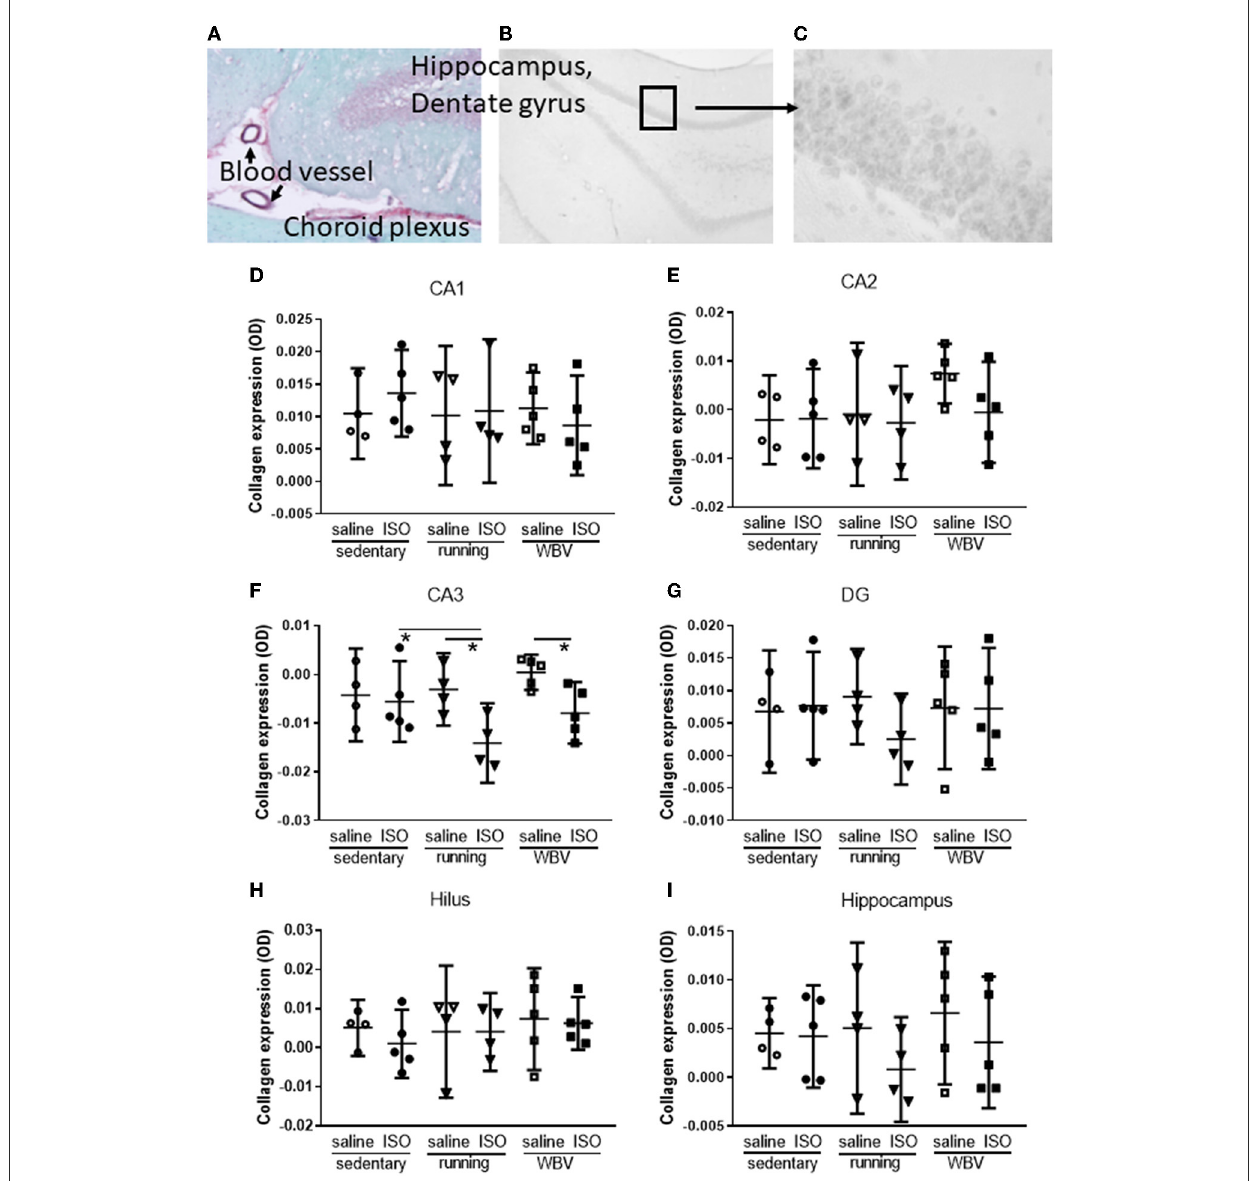
FIGURE4 (A) Example of hippocampal dentate gyrus stained with Sirius red (red) and Fast green (green), showing positive staining for collagen (red) in blood vessel walls, fibrous tissue of the choroid plexus, and the granular layer of the dentate gyrus, indicating the presence of collagen in brain tissue (50 × magnification). (B) A typical example of a black and white photograph of a section stained with Sirius red only (magnification 20 × ). (C) Detail of (B) as was used to quantify gray values (100 × magnification). (D–H) Actual measurements of optical density in the different areas of the hippocampus,